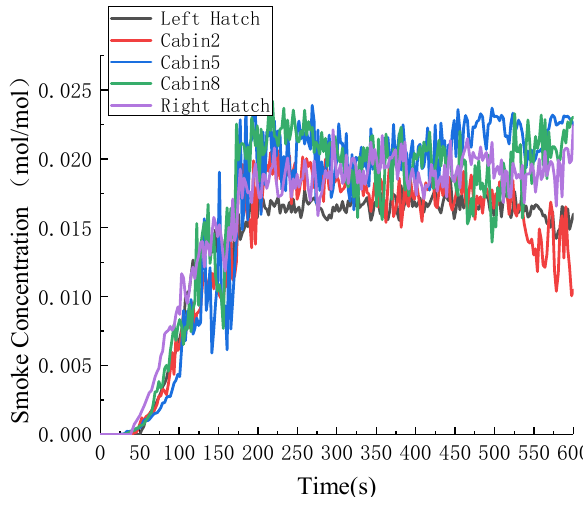
Figure 6. Smoke concentration curve.